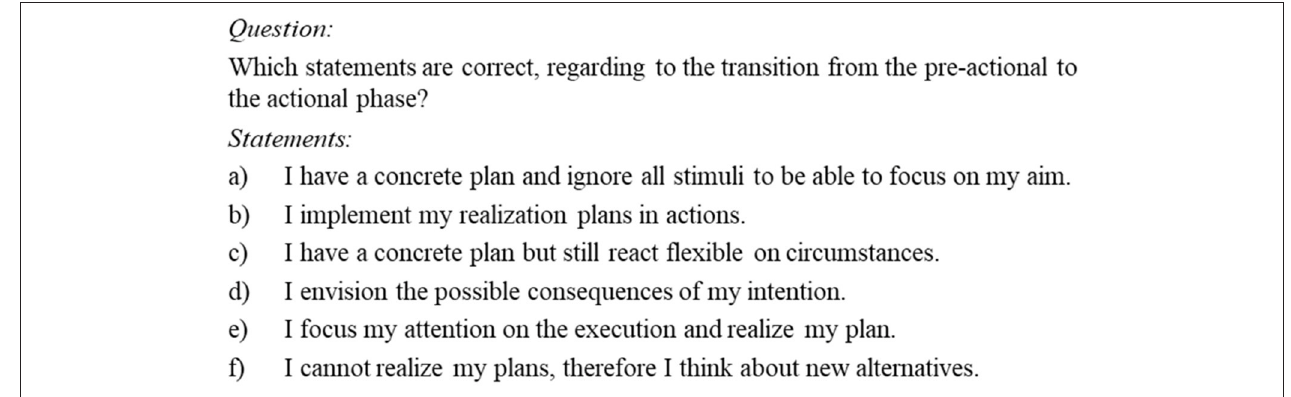
FIGURE 2 | Example of a question with six statements of the knowledge test (translated).